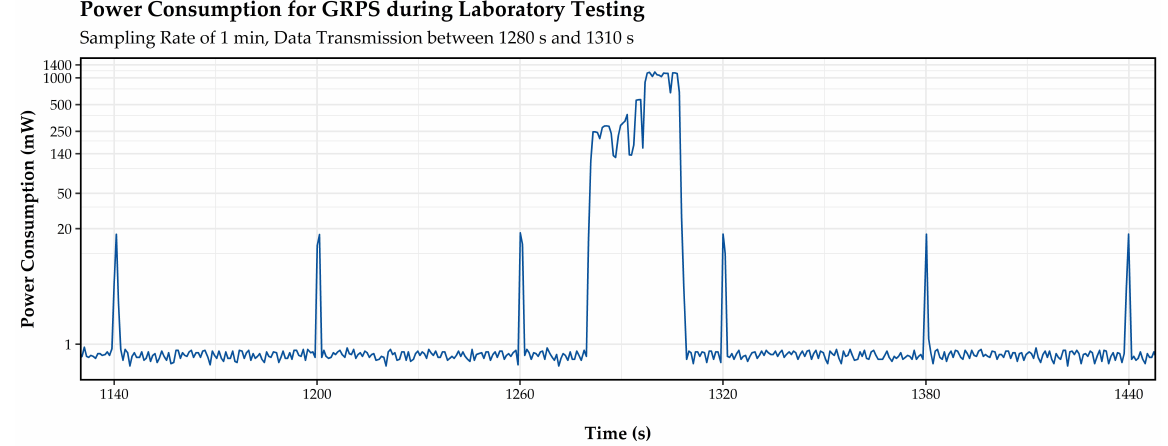
Figure 7. Energy-consumption time series for the EPMD with GPRS.